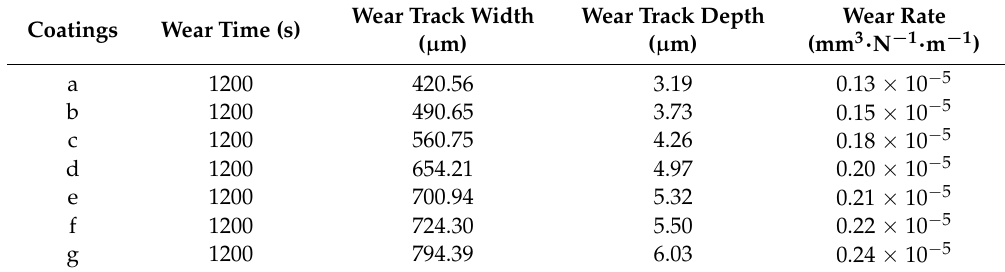
Table 4. Wear rates of the MAO coatings formed on aluminum alloys at different anode pulse-widths.